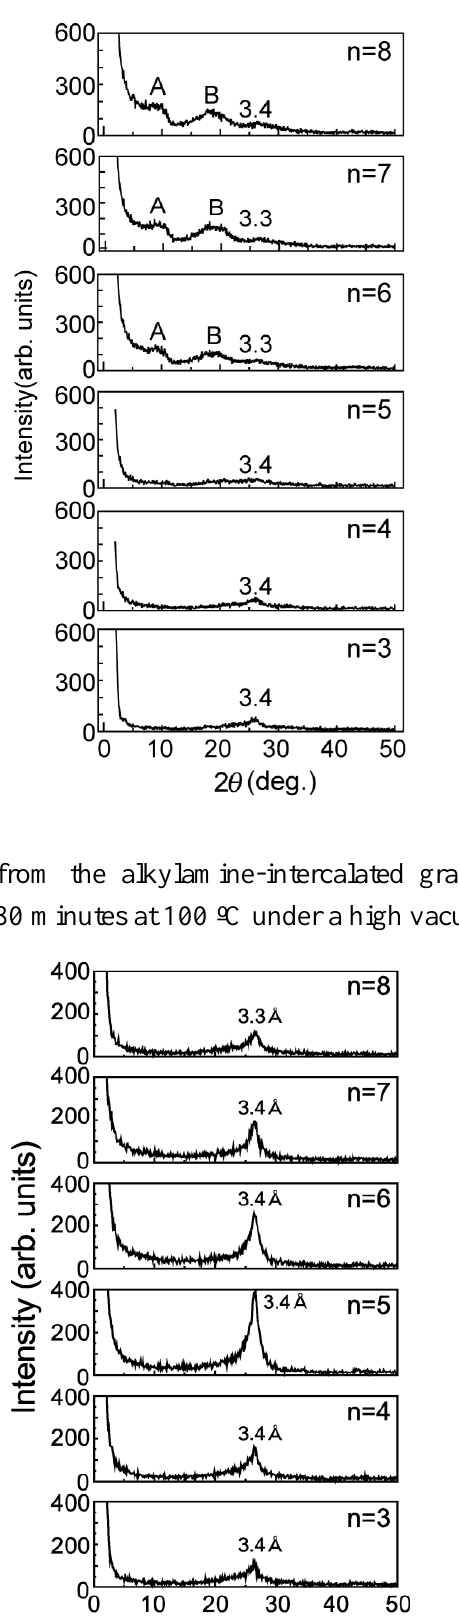
specimens of Figure 1b after heating for 60